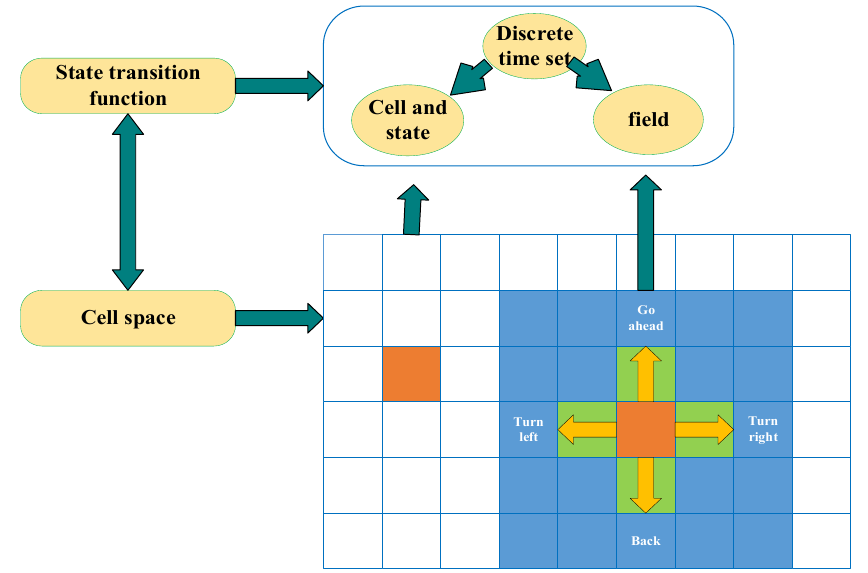
Figure 7. The structure of cellular automata.